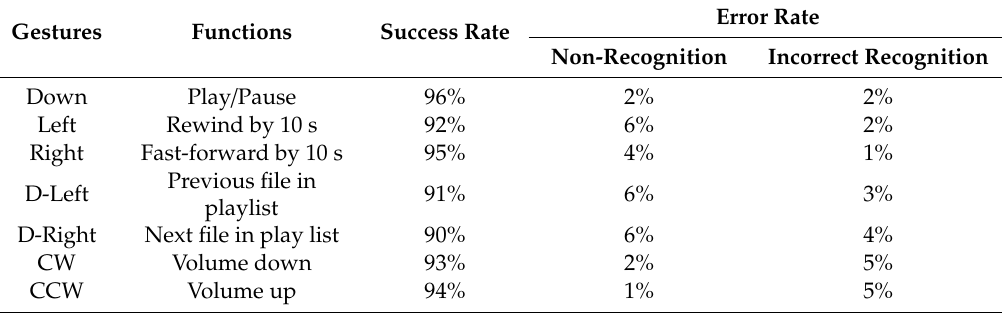
Table 6. Result of the multimedia playing software (participant = 5; trials =